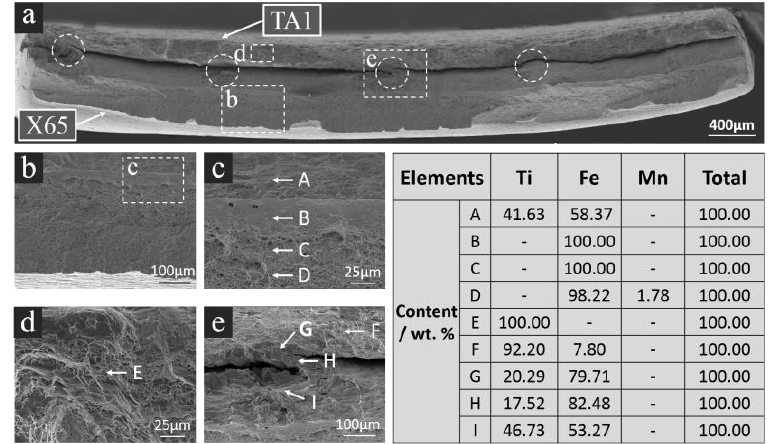
Figure 10. Morphologies and element distribution of the tensile fracture when the tensile direction was perpendicular to the direction of detonation wave propagation: ( a ) fracture morphology; and ( b – e ) b–e zone of a.